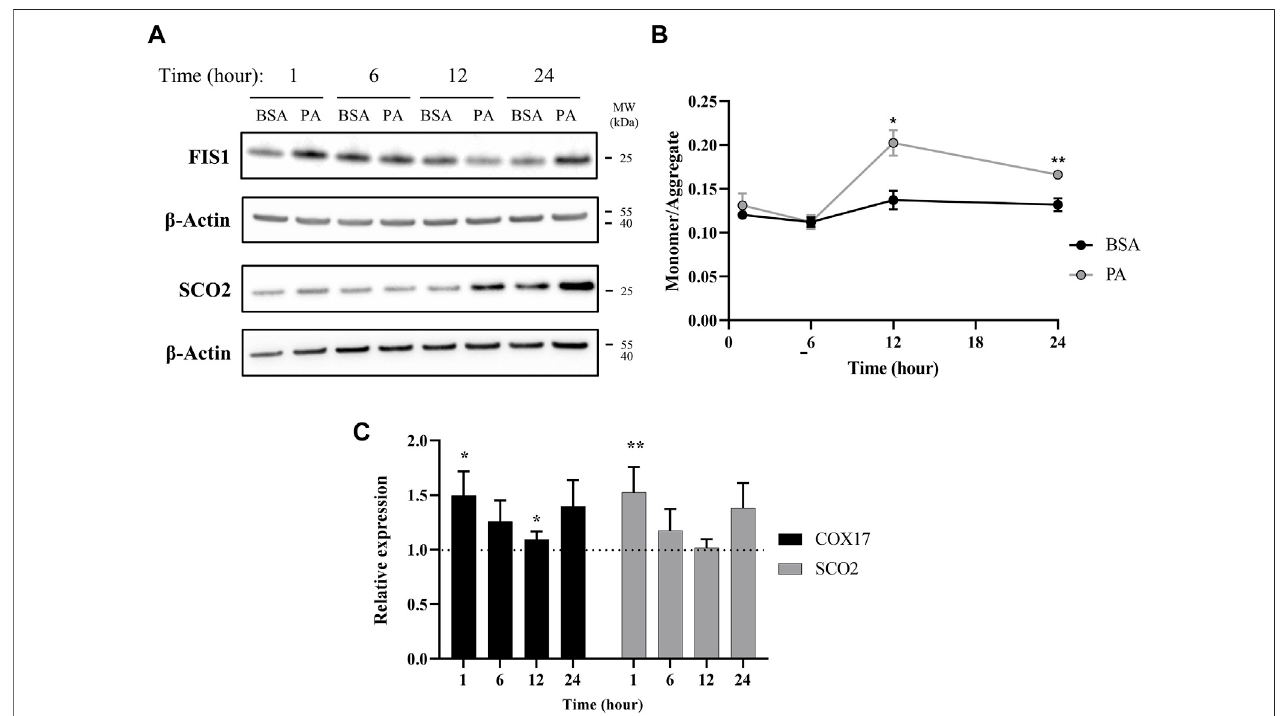
FIGURE 4 | Palmitate stimulations induce changes in mitochondria copper protein regulation. (A) Representative western blot images of SCO2 and FIS1 of cells stimulated with BSA or PA. (B) Mitochondrial membrane potential was measured using the JC-1 fl uorescent dye. Data are shown as monomer/aggregate fl uorescence of BSA- and PA-stimulated cells ( n = 4). Mean ± SEM is shown. The unpaired t -test was used to assess signi fi cance (* p < 0.05, ** p < 0.01). (C) Gene expression of COX17andSCO2withPA-stimulatedHepG2cellsrelativetoBSA-stimulatedcells( n =10)withnormalizationto β -actinasthehousekeepinggene.Mean±SEMis shown. The Mann – Whitney U test was used to assess signi fi cance (* p < 0.05, ** p <